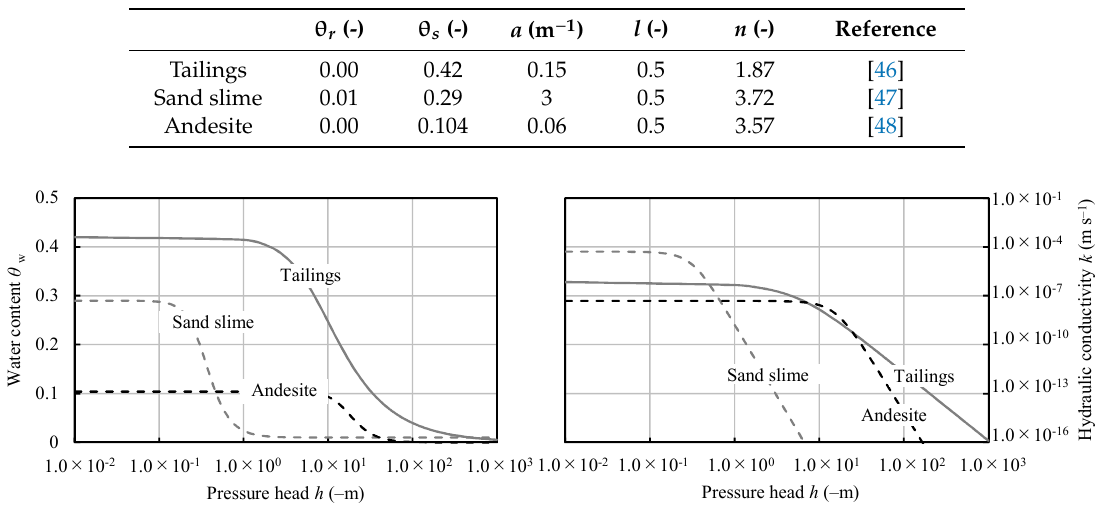
Table 3. Residual water content θ r , saturated water content θ s , and van Genuchten parameters a , l , and n [45].